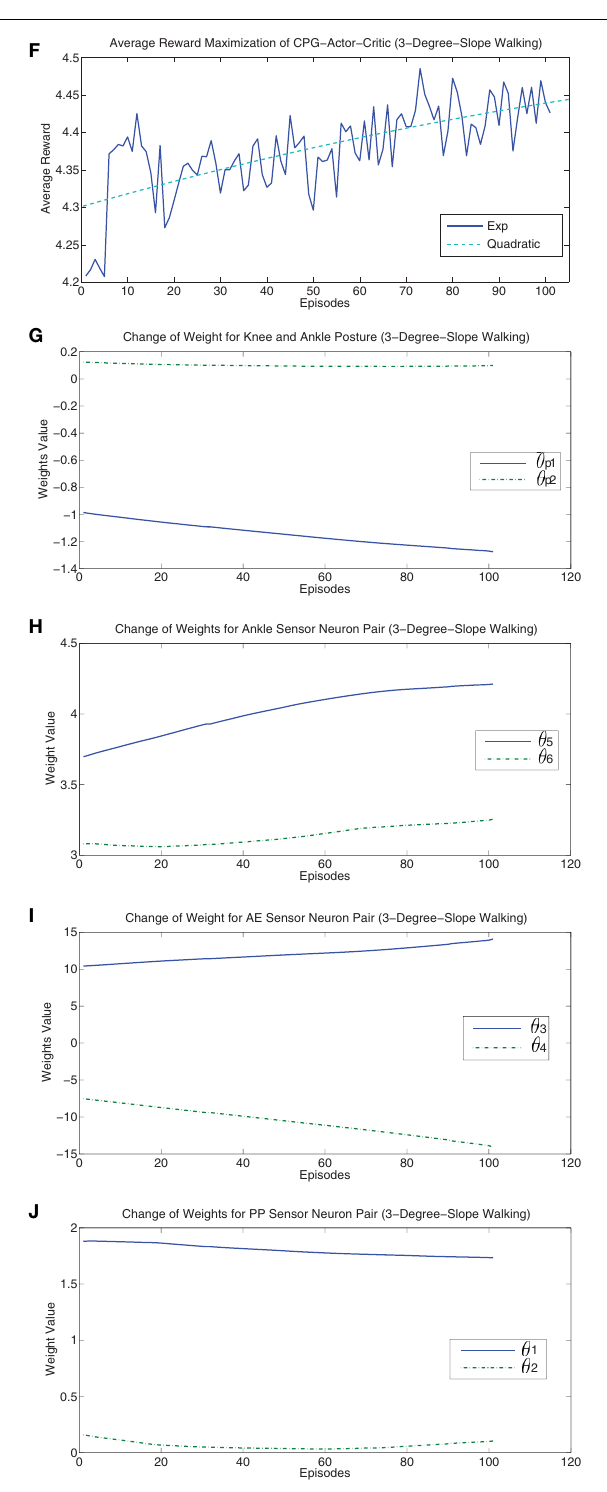
FIGURE 5 | Left column:The results of the runs with top-five reward on flat ground. (A) shows the maximization of average reward for the five runs. (B–E) show the results of the run with highest average reward (Exp 5) regarding how connection weights are updated in each CPG by learning process with respect to the contributions of each term respectively. Right colunm:The results of a run on 3˚ critical slope.